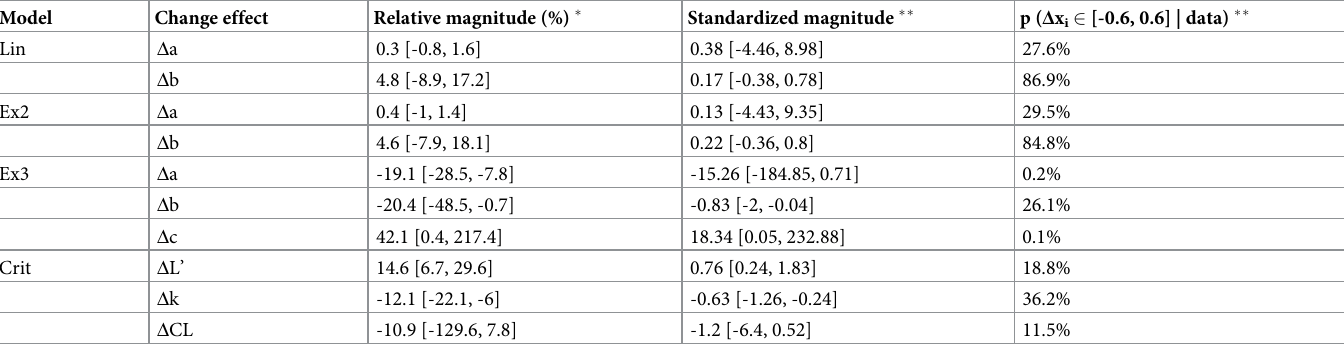
Table 3. Summary of posterior predictive distributions of relative and standardized change